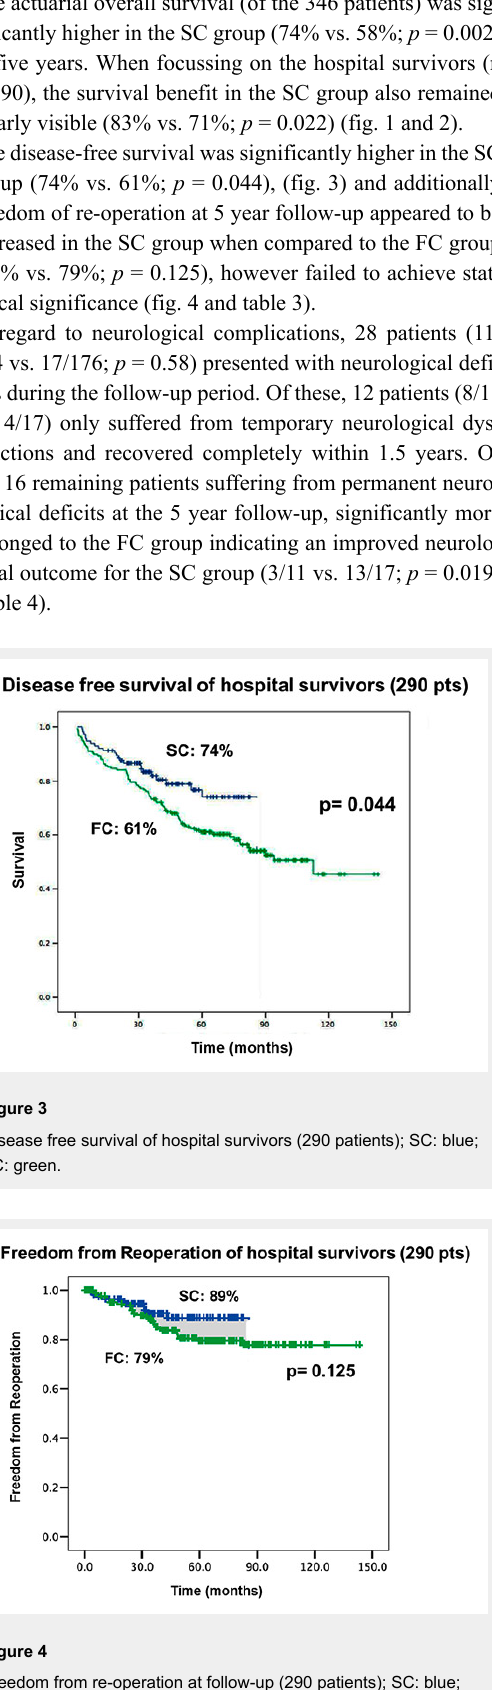
Freedom from re-operation at follow-up (290 patients); SC: blue; FC: